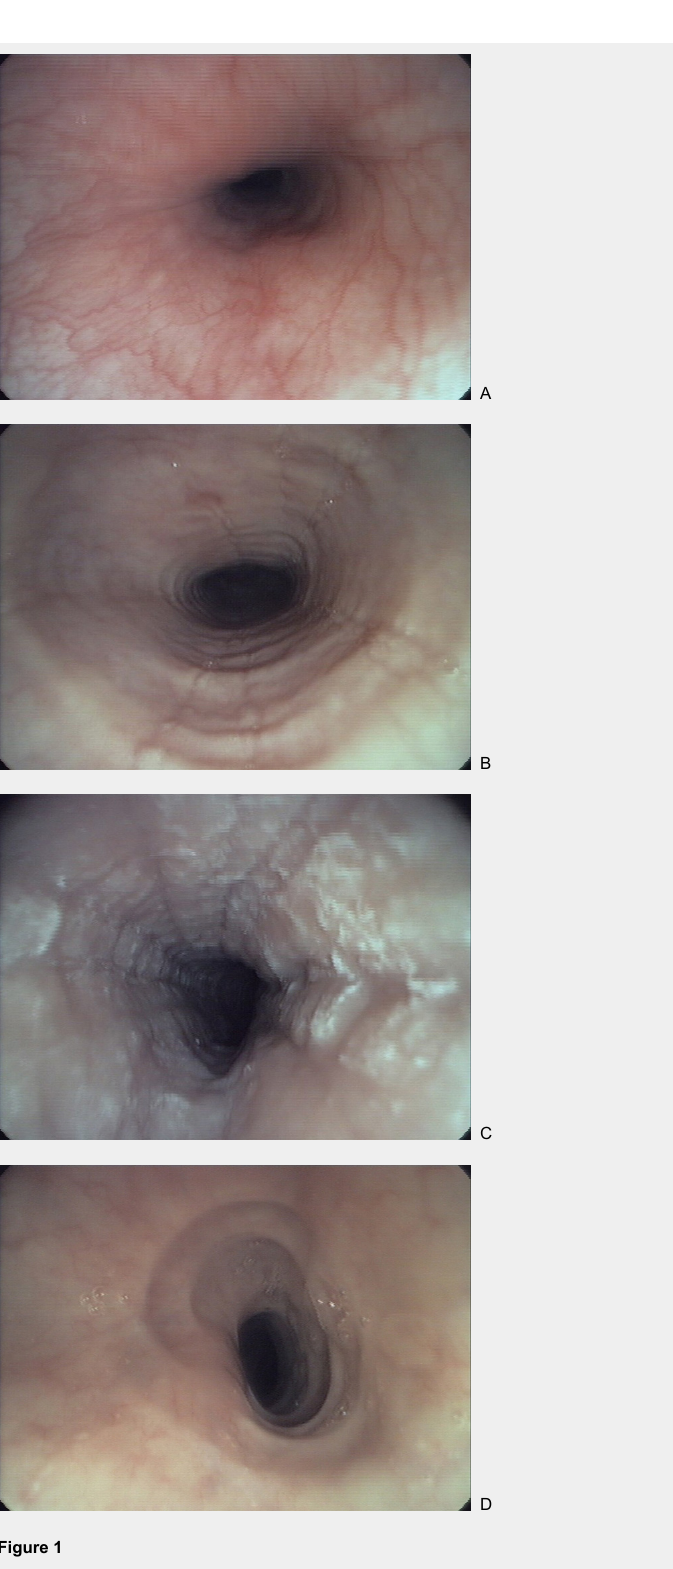
Endoscopic pictures illustrating the major endoscopic signs of EoE: Panel A illustrates the endoscopic appearance of a healthy esophagus. Panel B represents a moderate inflamed esophagus with edema, longitudinal furrowing and mild non-stenosing trachealisation. Panel C shows a severe inflamed esophagus with edema, white exudates and deep furrowing. Panel D illustrate signs associated with remodeling such as stricture due to fixed esophageal